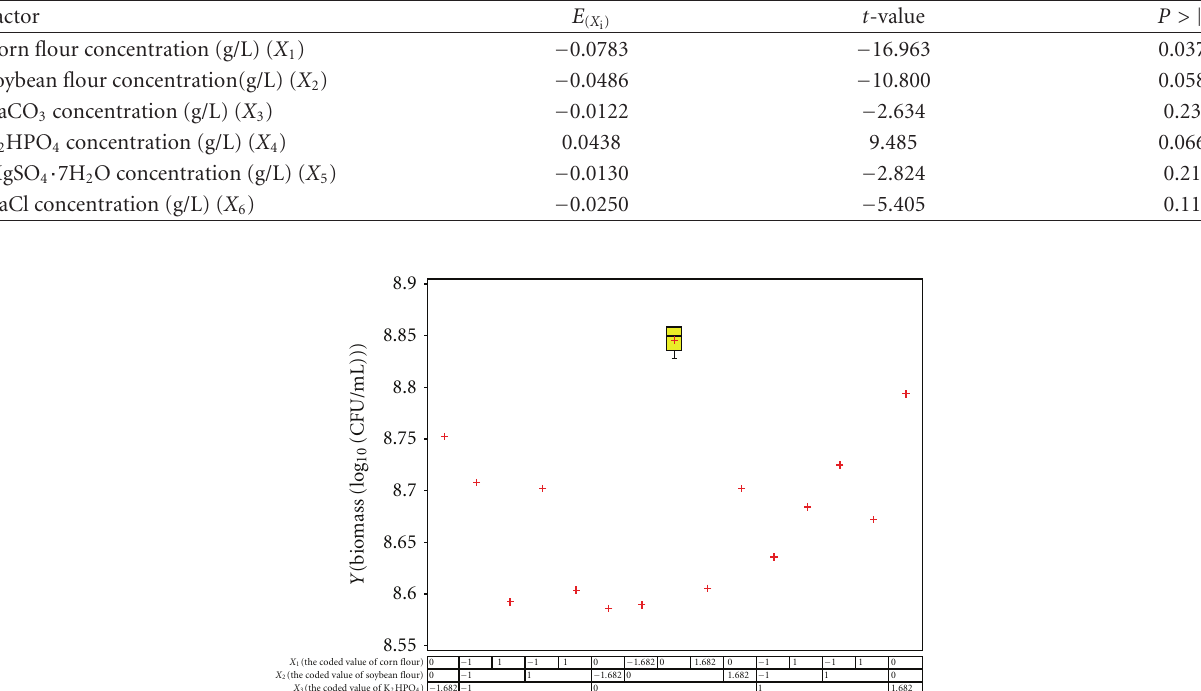
Table 4: The e ff ect of variables in the Plackett-Burman Design and associated statistical tests.